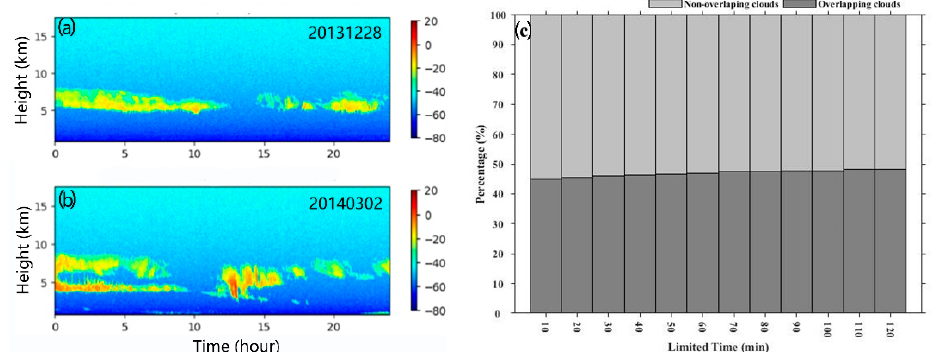
Figure 1. Depiction of cloud overlap, ( a ) non-overlapping cloud, ( b ) overlapping cloud, and the color represents reflectivity factor (dBZ). ( c ) The percentage of non-overlapping and overlapping clouds of KAZR for the period 2013–2019 at different limited time.